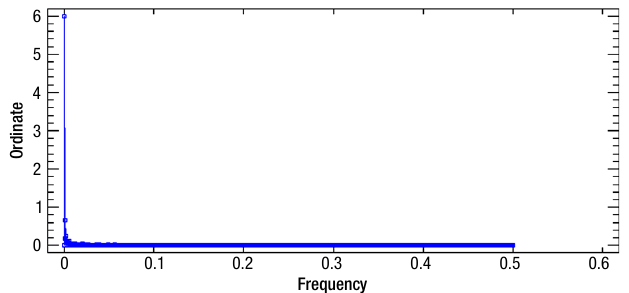
Fig. 4. Residual autocorrelations for time series of Overnight 2000–2008